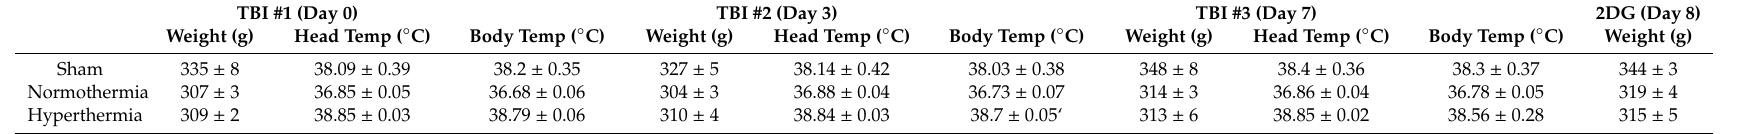
Table 1. Animal weight and temperature during surgical